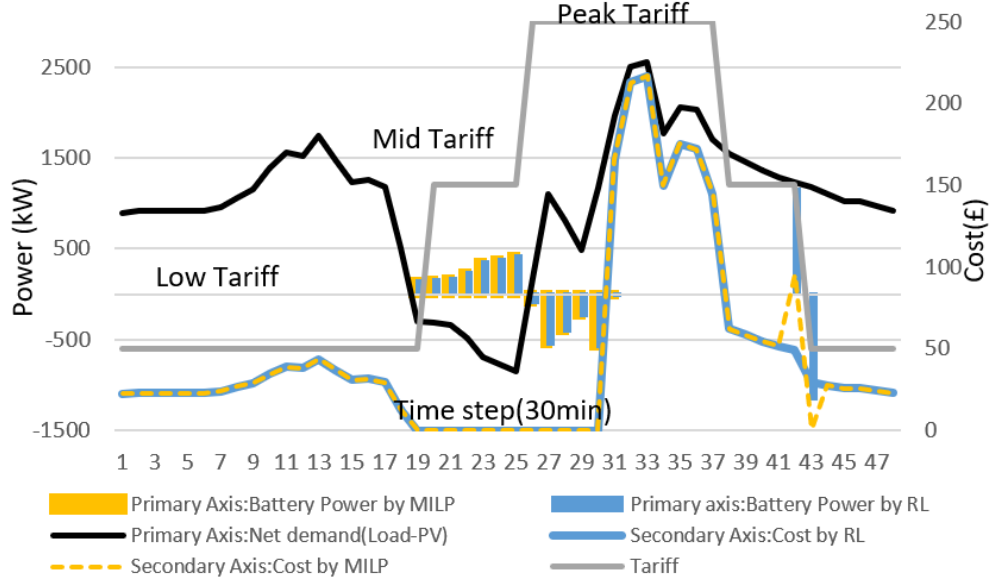
Figure 7. Comparison between MILP and RL in terms of cost per hour.